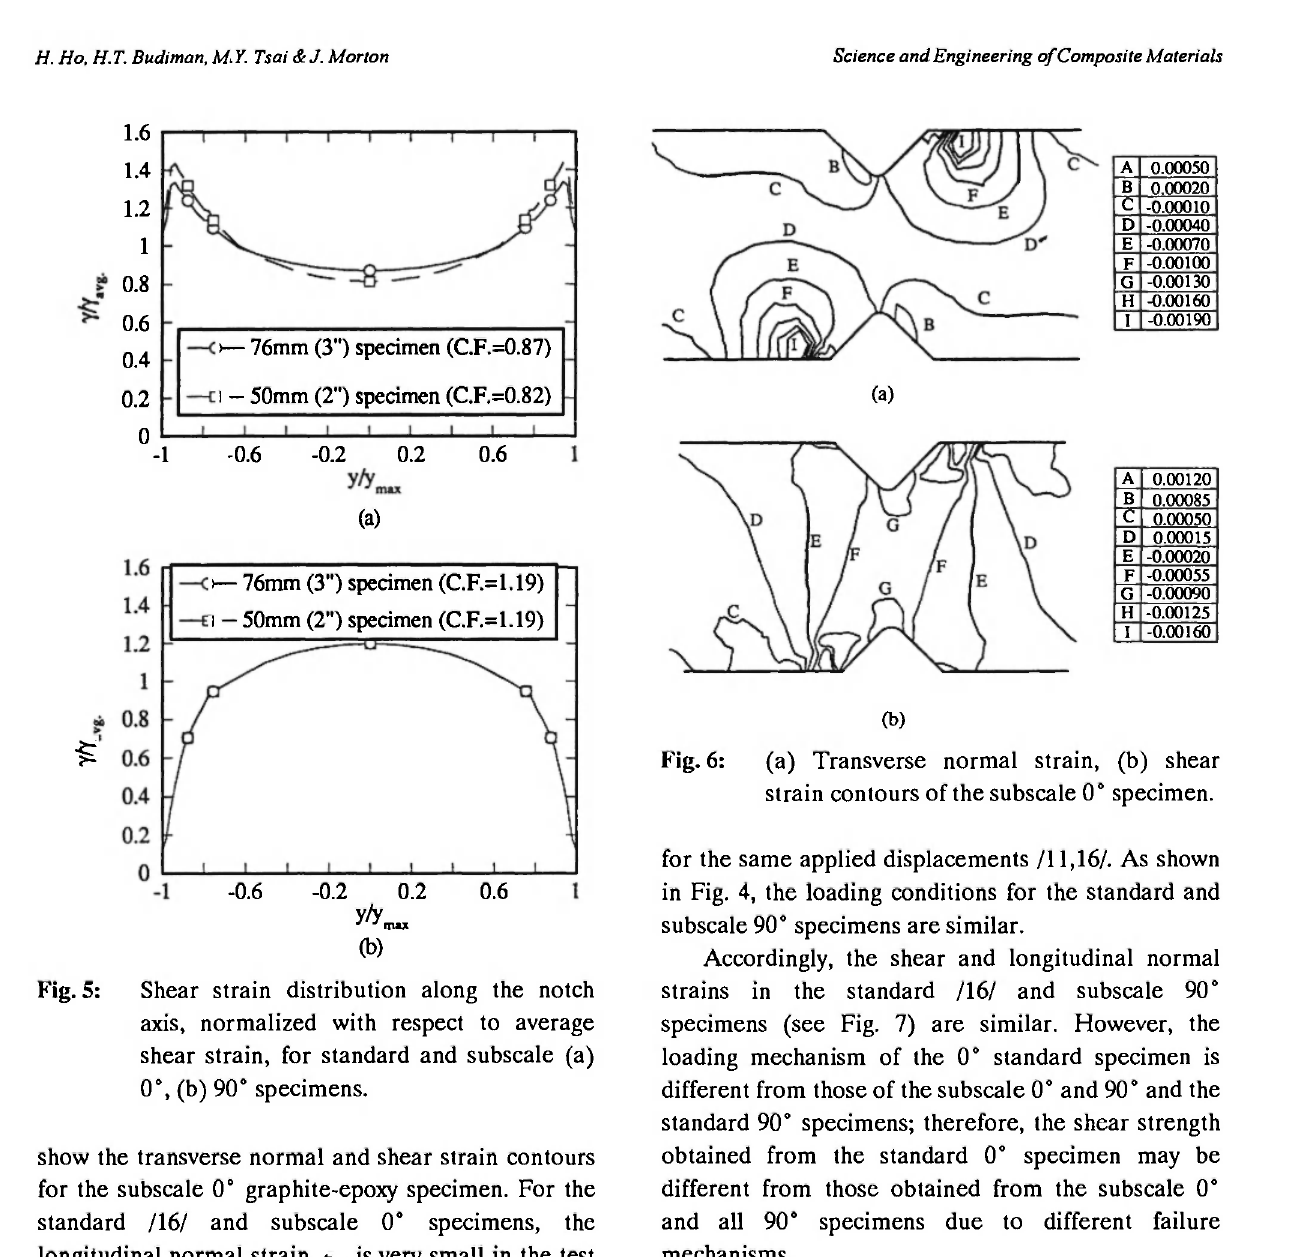
Fig. 6: (a) Transverse normal strain, (b) shear strain contours of the subscale 0° specimen. for the same applied displacements /ll, 16/. As